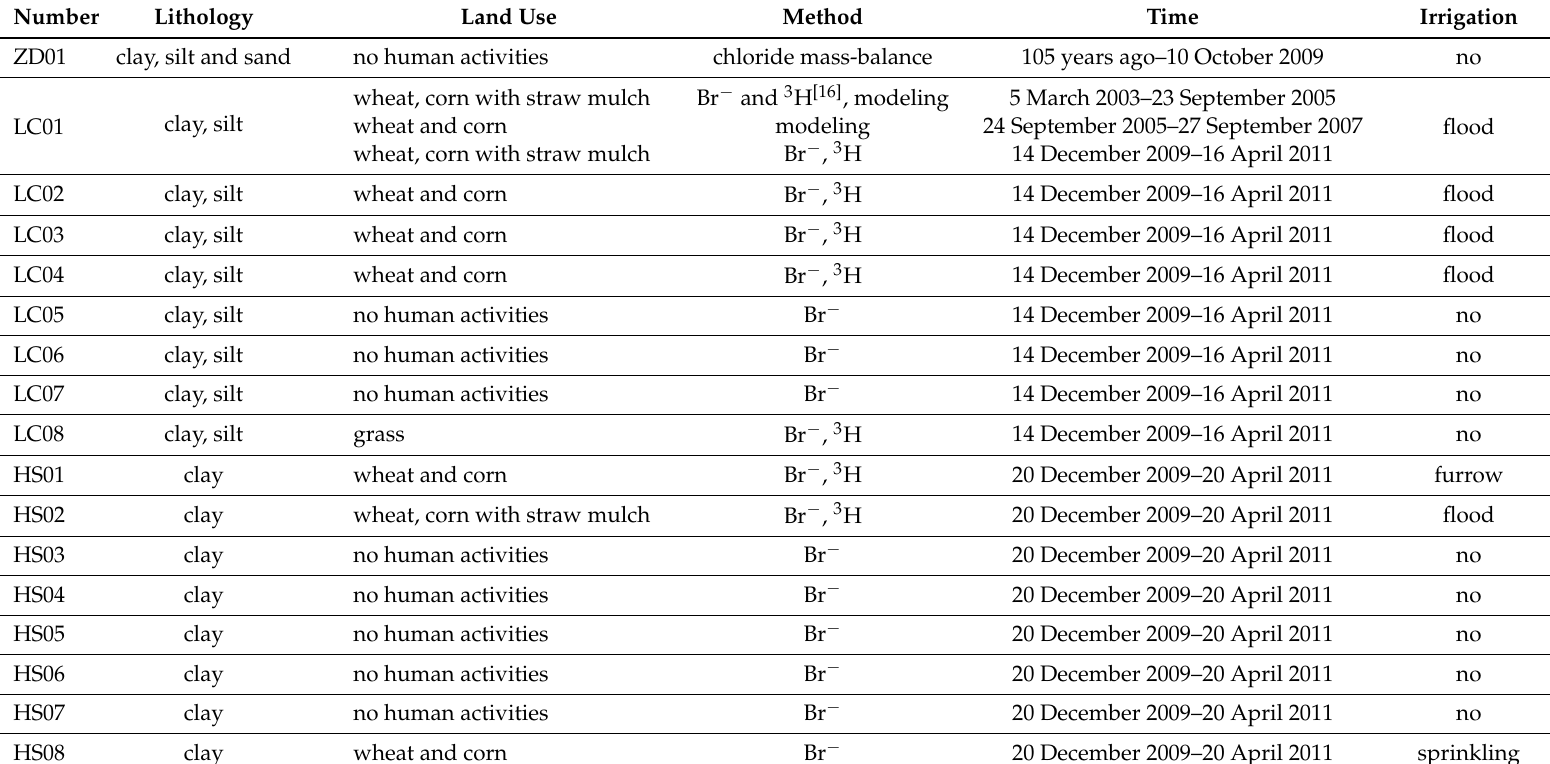
Table 2. Estimation methods of representative areas in